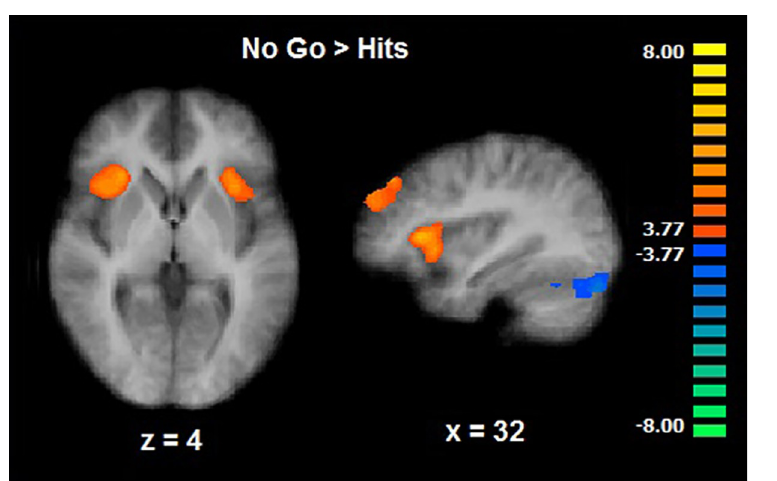
Fig 7. General inhibition–Go/No-go task. Brain activations during the No-go trials (CLTC p <